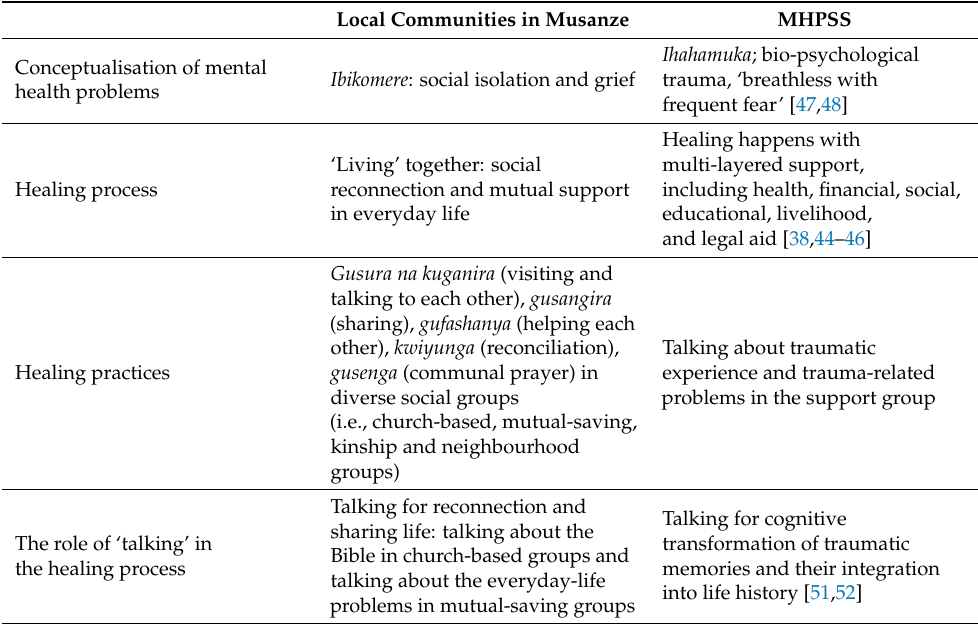
Table 4. Healing processes of local communities in Musanze and mental health and psychosocial support